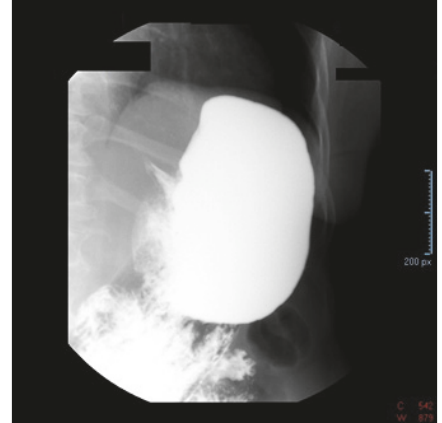
Figure 5: Barium swallow showing resolution of bird beak appear- ance with complete filling of the